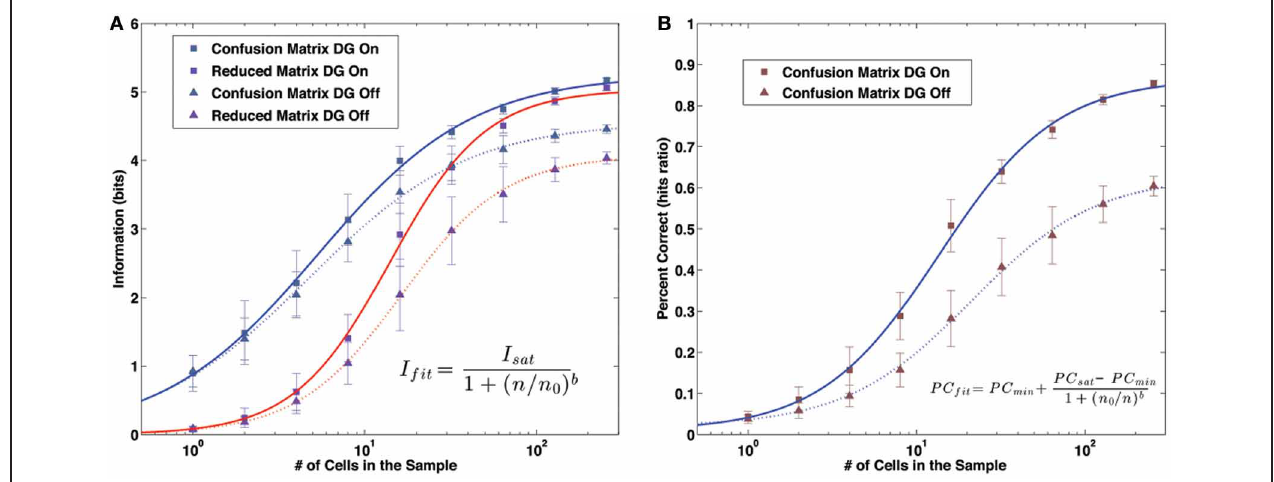
Square markers/solid lines: results with the DG input active. Triangular markers/dashed lines: results without the DG input. (B) Percent Correct values. Markers: model data. Lines: fit curves, as in (A)